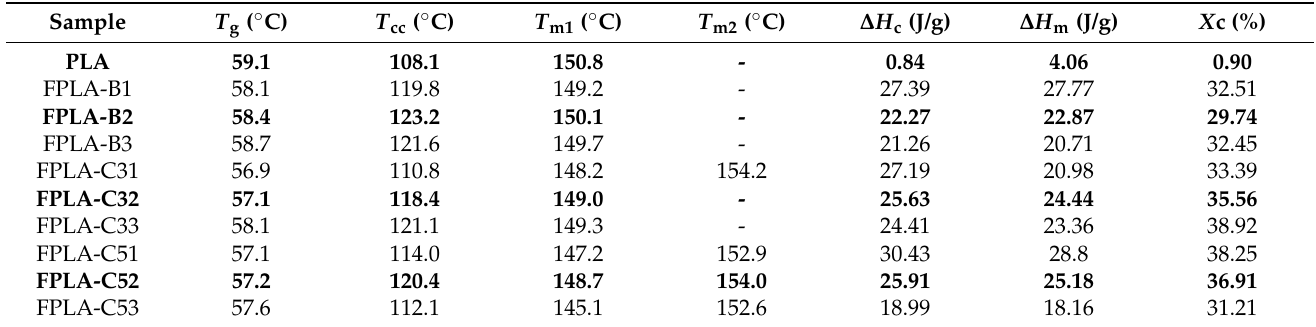
Table 2. DSC indices for PLA and FPLA